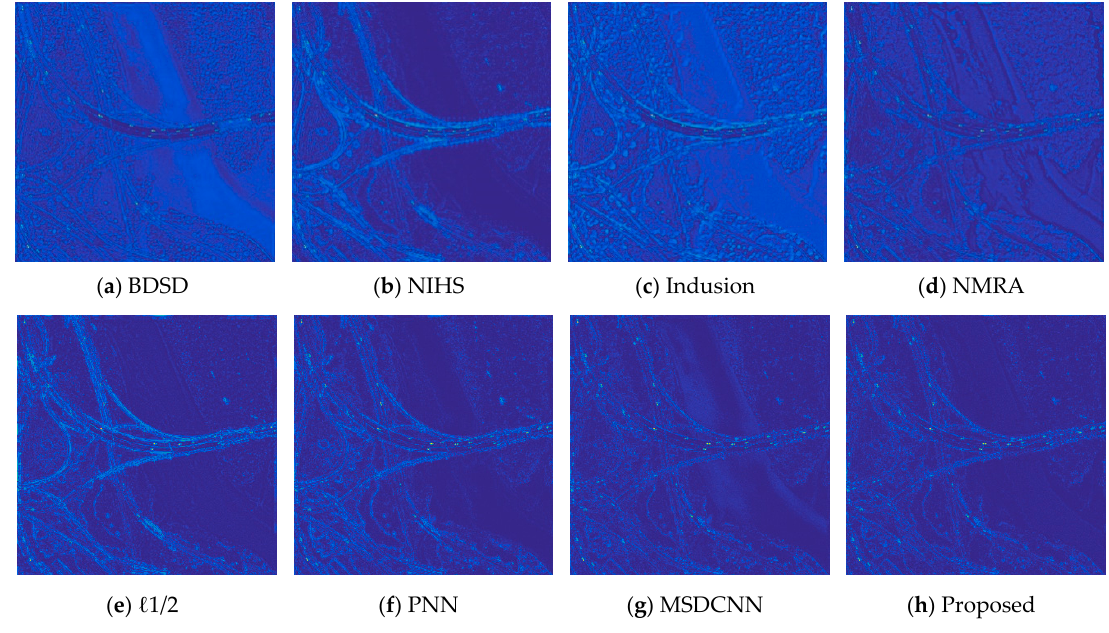
Figure 7. The residual images corresponding to Figure 6. ( a ) BDSD; ( b ) NIHS; ( c ) Indusion; ( d ) NMRA;